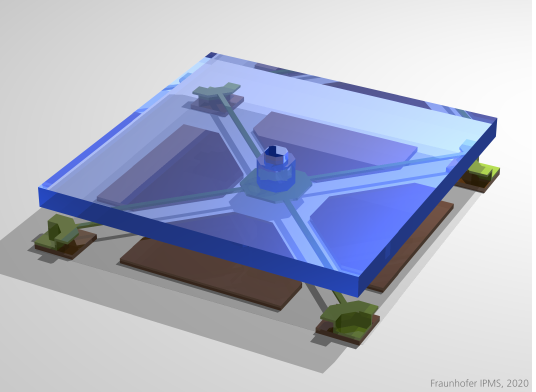
Figure 3. Schematic image of a two-axis tilting